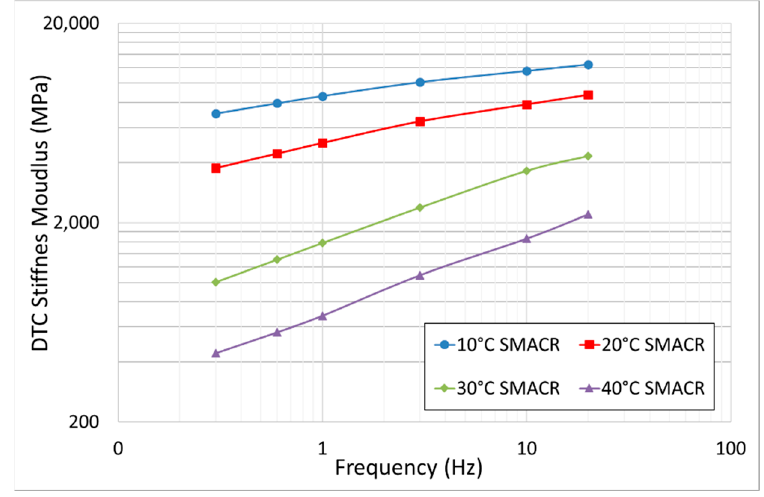
Figure 3. Direct tension-compression ( DTC) Isothermal curves for SMACR.